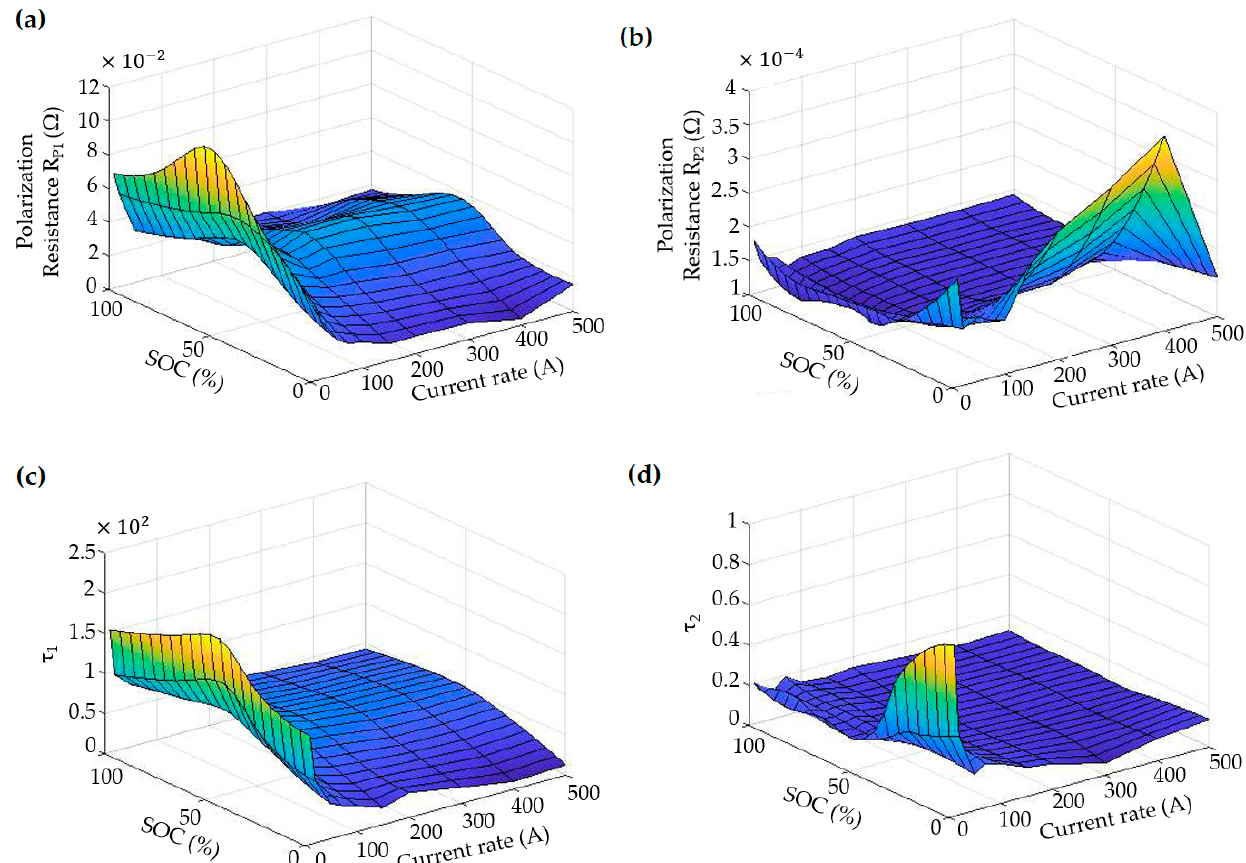
Figure 7. The electrical parameters of the second-order ECM at 25 °C: ( a ) the polarization resistance for the first RC branch, ( b ) the polarization resistance for the second RC branch, ( c ) the time constant for the first RC branch, ( d ) the time constant for the second RC branch.